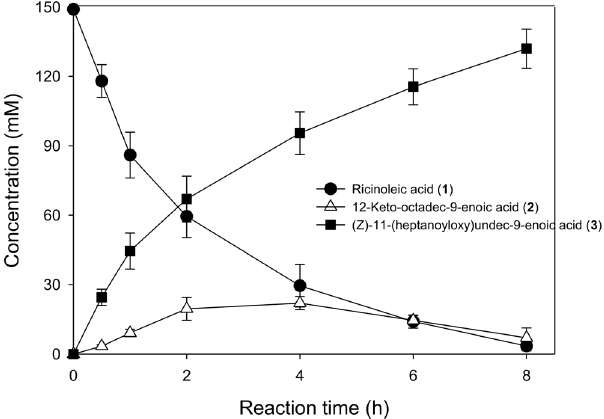
Figure 6. Time course of the biotransformation of ricinoleic acid by the recombinant E . coli BL21(DE3) pAPTm- E6BVMO C302L -ADH, pACYC-FadL expressing the long chain fatty acid transporter FadL in the outer membrane in addition to the ADH and E6BVMO C302L . The biotransformation was initiated by adding 150 mM ricinoleic acid and 0.5 g/L Tween80 into the recombinant E . coli culture broth (cell density: 25 g CDW/L). Glucose was added into the cultivation medium to a rate of 5 g/L/h to facilitate regeneration of the nicotinamide cofactors in E . coli cells. Symbols indicate the concentrations of ricinoleic acid ( 1 ) ( ● ), 12-keto-octadec-9- enoic acid ( 2 ) ( △ ), and the ester (3) ( ■ ). The experiments were performed in triplicate. The error bars indicate standard